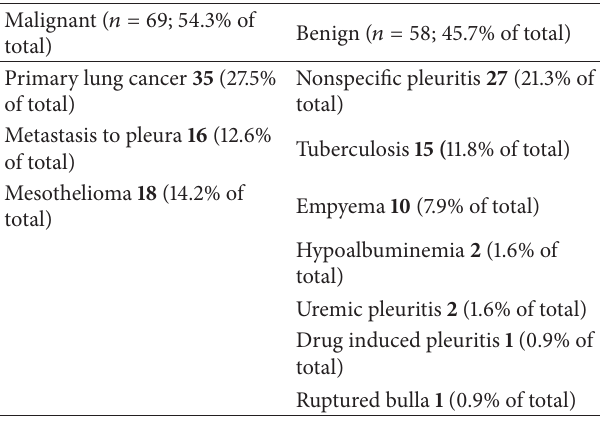
Table 2: Diagnostic outcome of medical thoracoscopy in 127 patients.